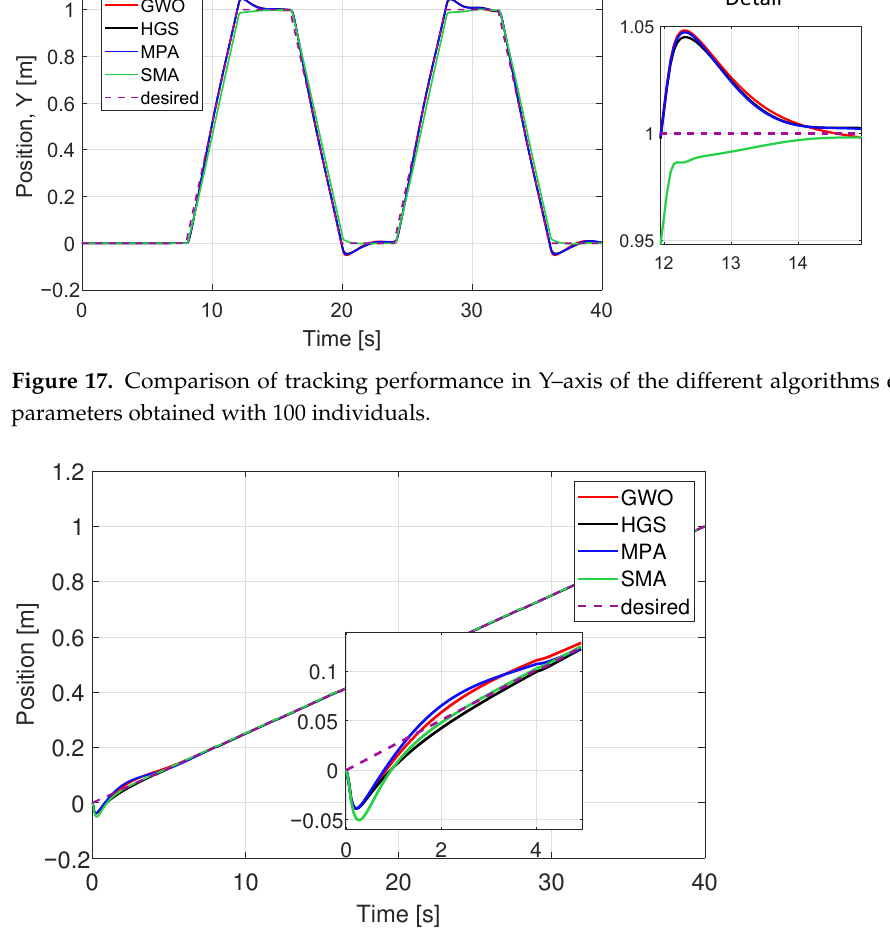
Figure 18. Comparison of tracking performance in Z–axis of the different algorithms evaluating parameters obtained with 100